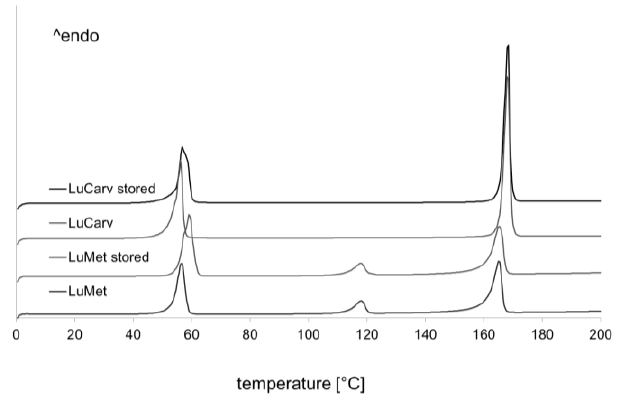
Figure 8. DSC thermograms of melt-extrudates; LuCarv und LuMet before and after storing for nine months at accelerated conditions (40 °C, 75% relative